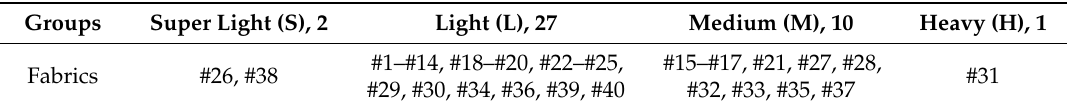
Table 3. Groups for collected fabrics.